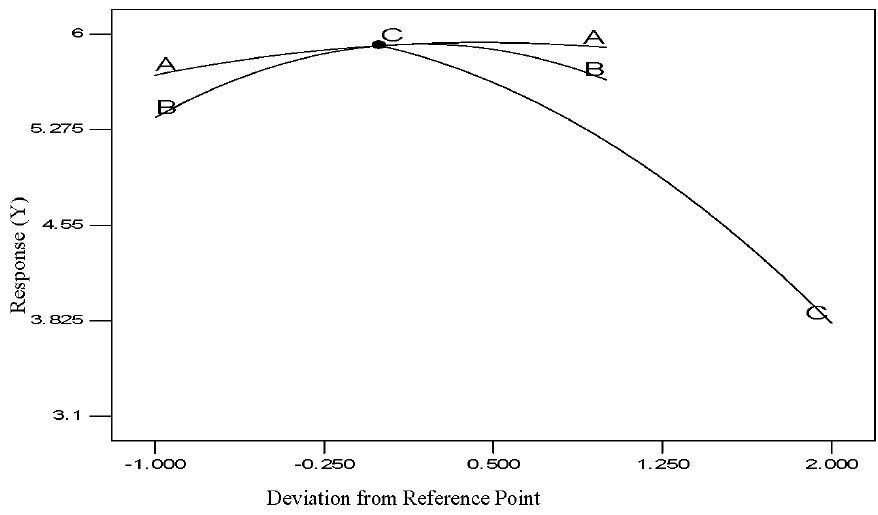
Figure 7. Deviation graph of process